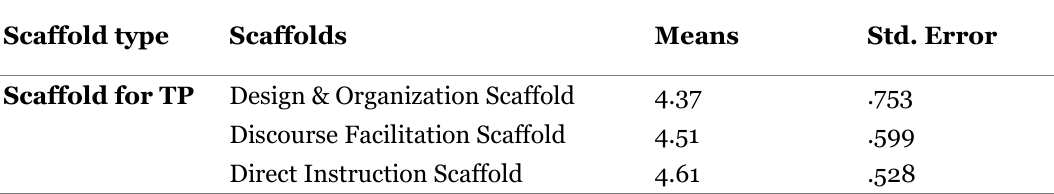
Survey Results on Effectiveness of Scaffolds for Teaching Presence